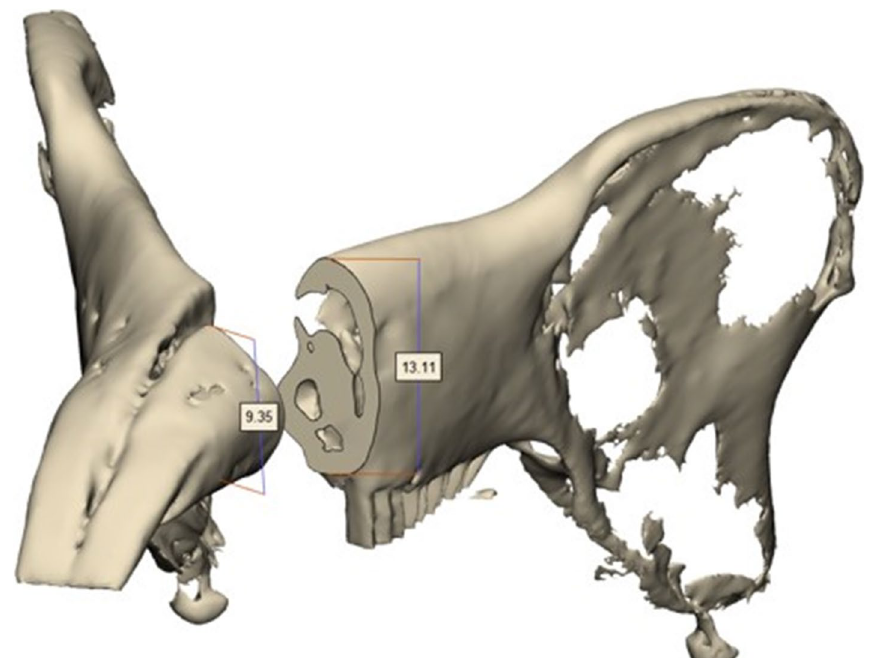
Fig. 4 Measurement of the planned resection part length anterior height and posterior height and anteroposterior length of the upper and lower